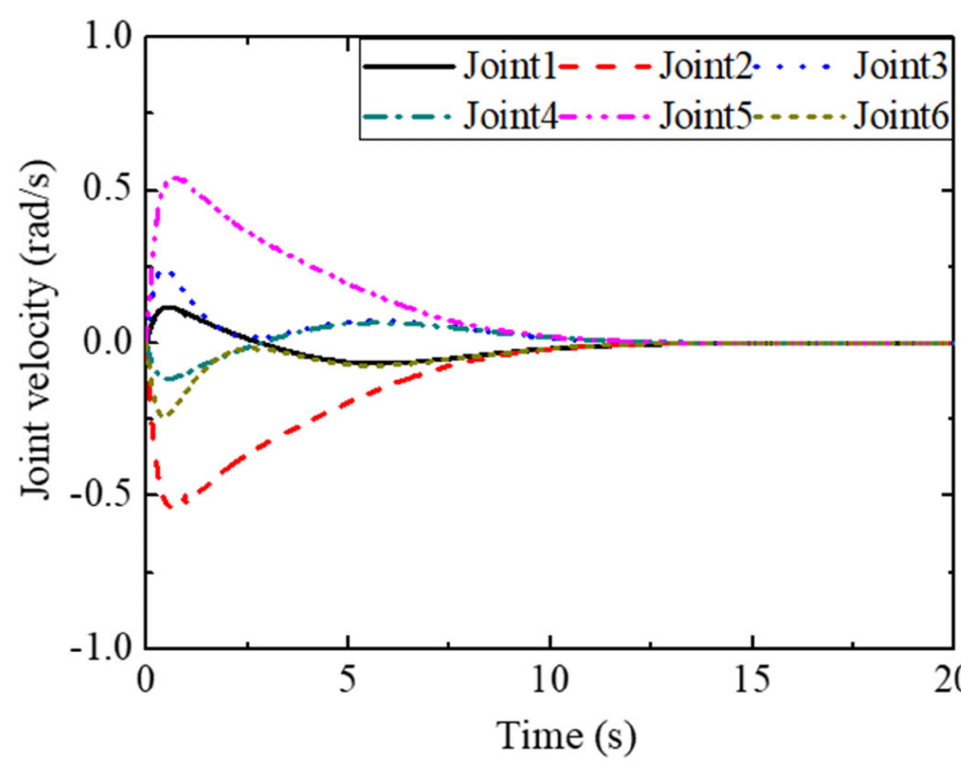
Figure 8. Joint velocities in the preassembly stage.